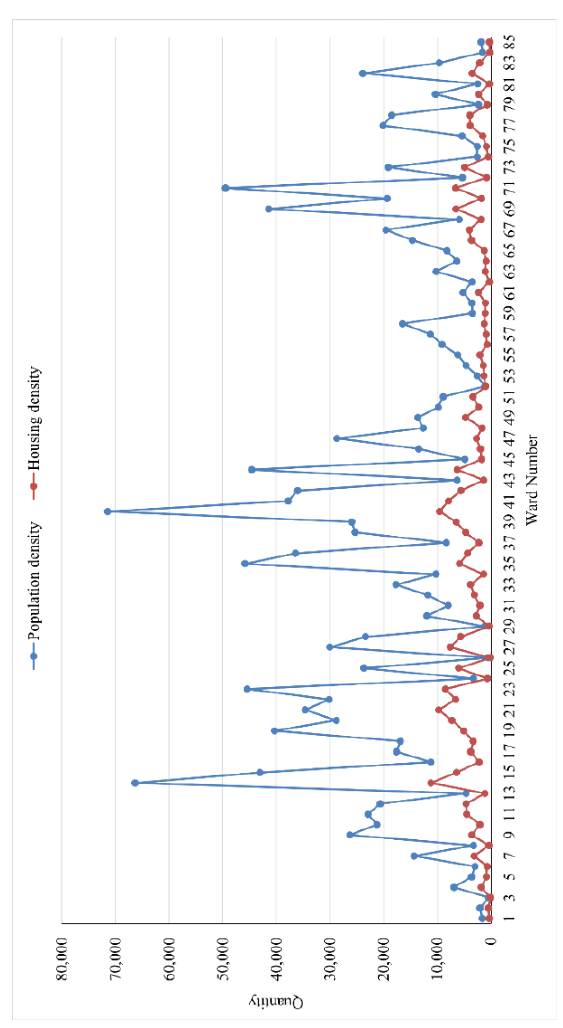
Figure 3. Ward-wise distribution of Population Density and Housing Density